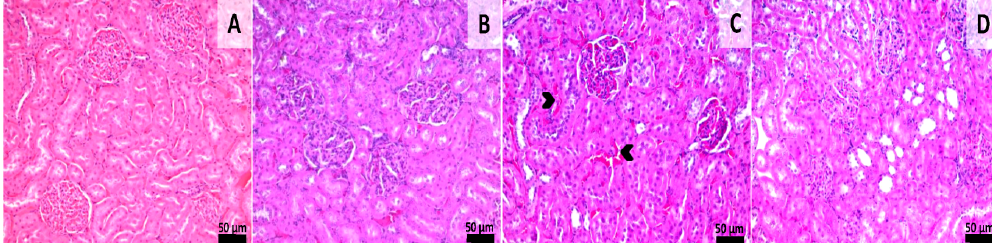
Figure 7. Histology of kidney sections. Group 1 ( A ) showing normal renal morphology. Group 2 ( B ), normal morphology Group 3 ( C ), Congestion in the renal cortex (arrowheads), Group 4 ( D ), normal renal morphology, HE stain, Scale bar = 50 μm. Normal renal morphology, HE stain, Scale bar = 50 μm.